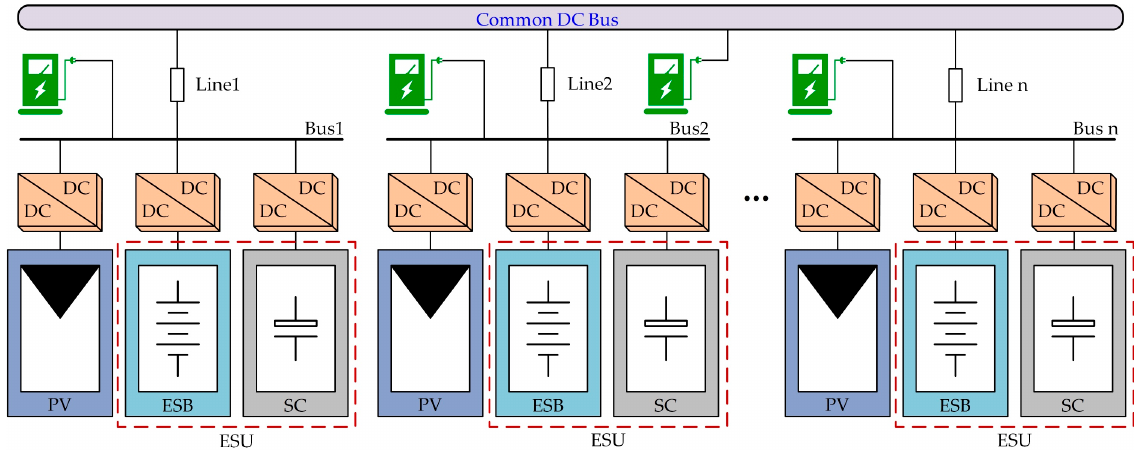
Figure 1. Structure diagram of the DC microgrid with integrated PV energy storage and charging.